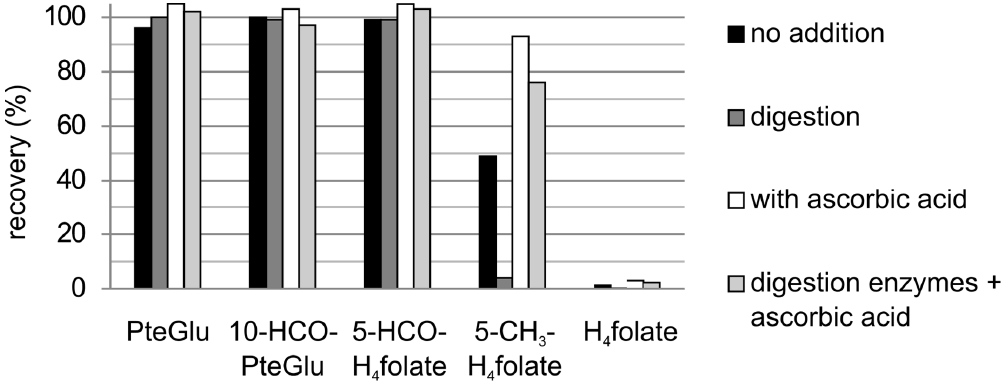
Figure 2. Recovery (%) of the single vitamers after the simulated digestion as total folate calculated as PteGlu depending on the addition of digestion juices and ascorbic acid.